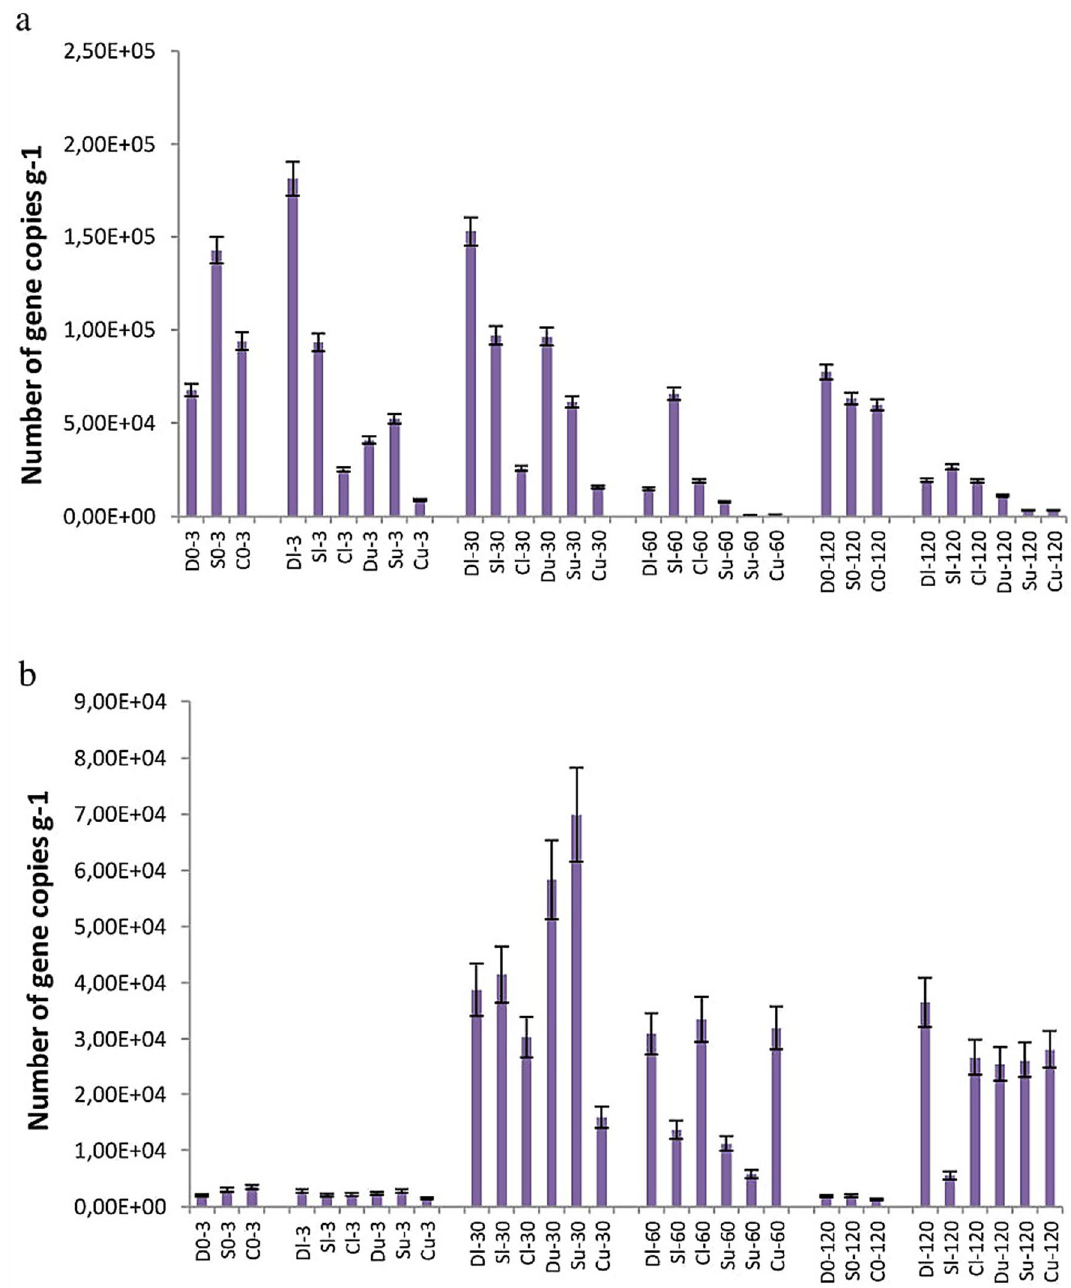
Figure 6. Gene copy numbers belonging to the groups GP-PAH ( a ) ( narAa, phdA/pdoA2, nidA/pdoA1, and nidA3/fadA1 described for Rhodococcus, Mycobacterium, Nocardioides , and Terrabacter ) and GN-PAH ( b ) ( nahAc, nahA3, nagAc, ndoB, ndoC2, pahAc, pahA3, phnAc, phnA1, bphAc, bphA1, dntAc , and arhA1 described for Pseudomonas, Ralstonia, Commamonas, Burkholderia, Sphingomonas, Alcaligenes, and Polaromonas